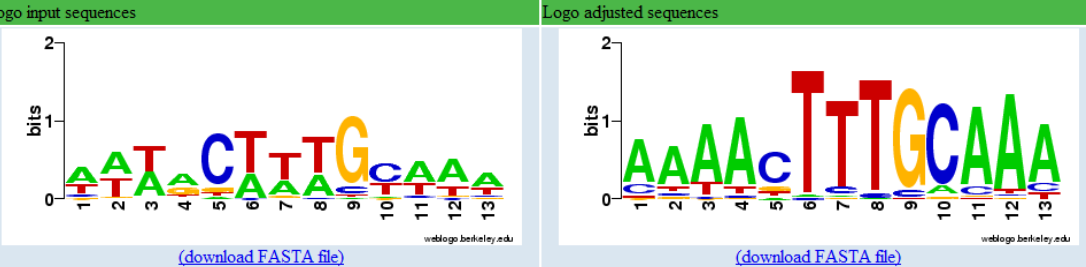
Figure 1: A screenshot from the MoRAine 2.0 web site. A comparison of the sequence logos con- structed from the original TFBSs (left side) for the transcription factor RamB of Corynebacterium glutamicum and the adjusted TFBSs by using MoRAine 2.0 (right